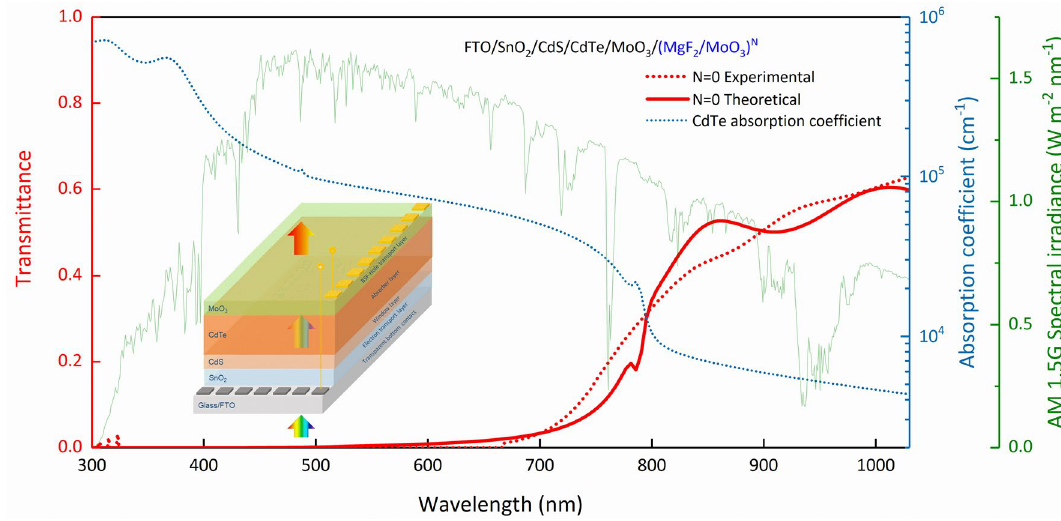
Figure 2. Experimental and TMM calculated transmittance spectra of FTO/SnO 2 /CdS/CdTe/MoO 3 /(MgF 2 / MoO 3 ) N SC for N = 0, change of absorption coefficient of CdTe and AM 1.5G spectral irradiance depending on wavelength. 1D-PC-free SC is given in the